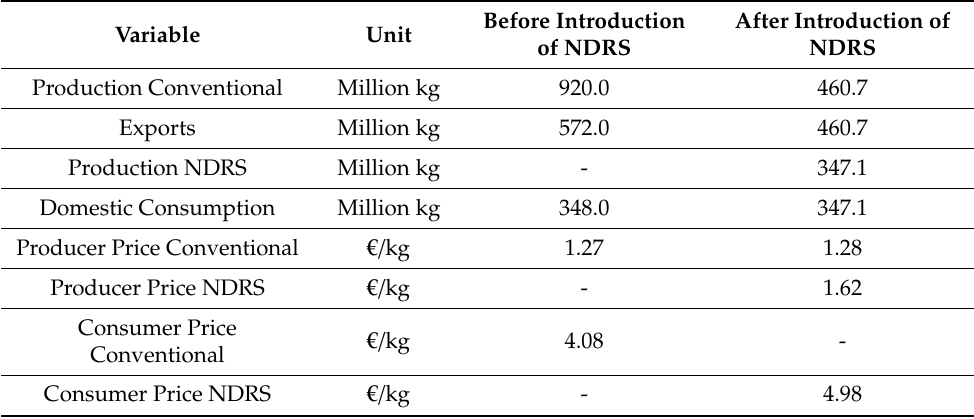
Table A1. Market figures of Dutch broilers before and after introduction of the New Dutch Retail Standard